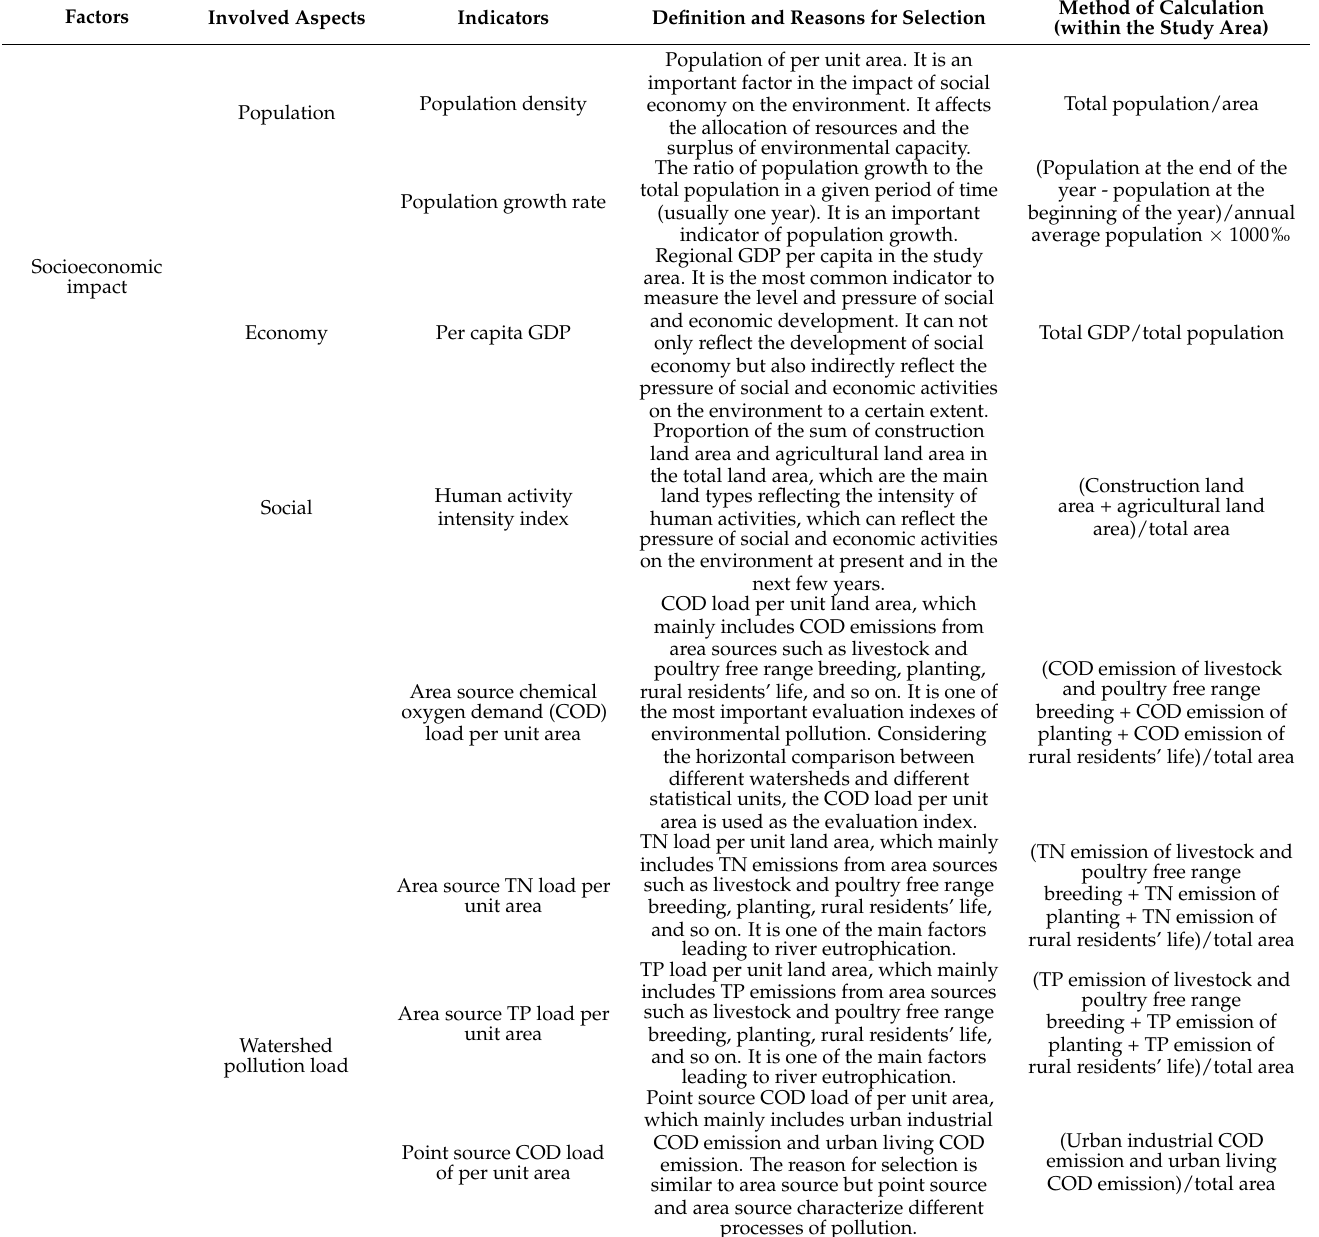
Table A1. Definition, reasons for selection, and calculation or acquisition method of each